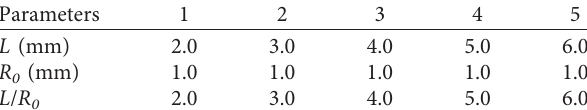
Table 1: The length/diameter ratio of valve spool.